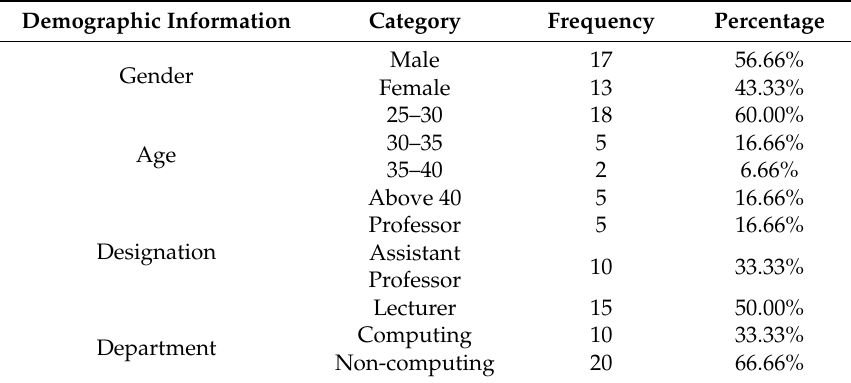
Table 3. Demographic